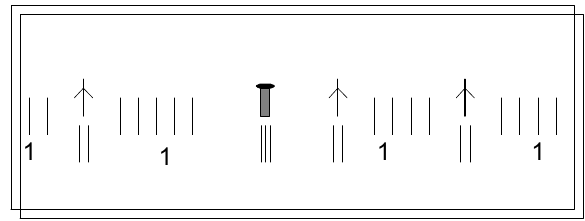
Fig 2. The diagram of the attack. Intervals between military personnel are about 10 m . Two soldiers operate a machine gun